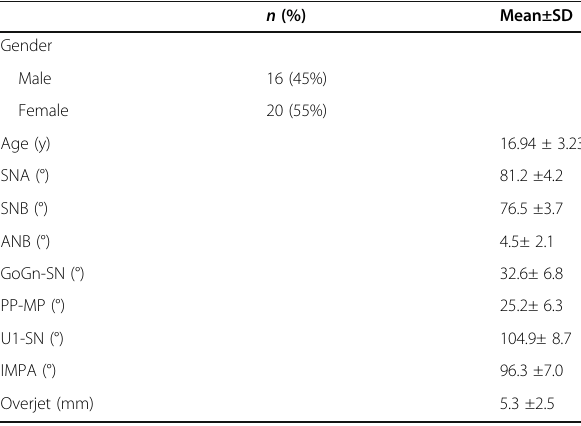
Table 2 Initial skeletal, dental, and demographic characteristics of the